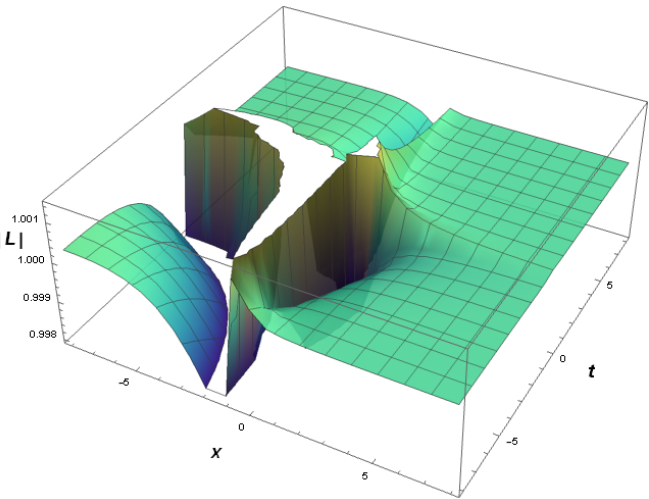
Figure 6. The 3D graph of dark singular solitary-wave solutions, i.e., | L 10 | across β = 0.3.